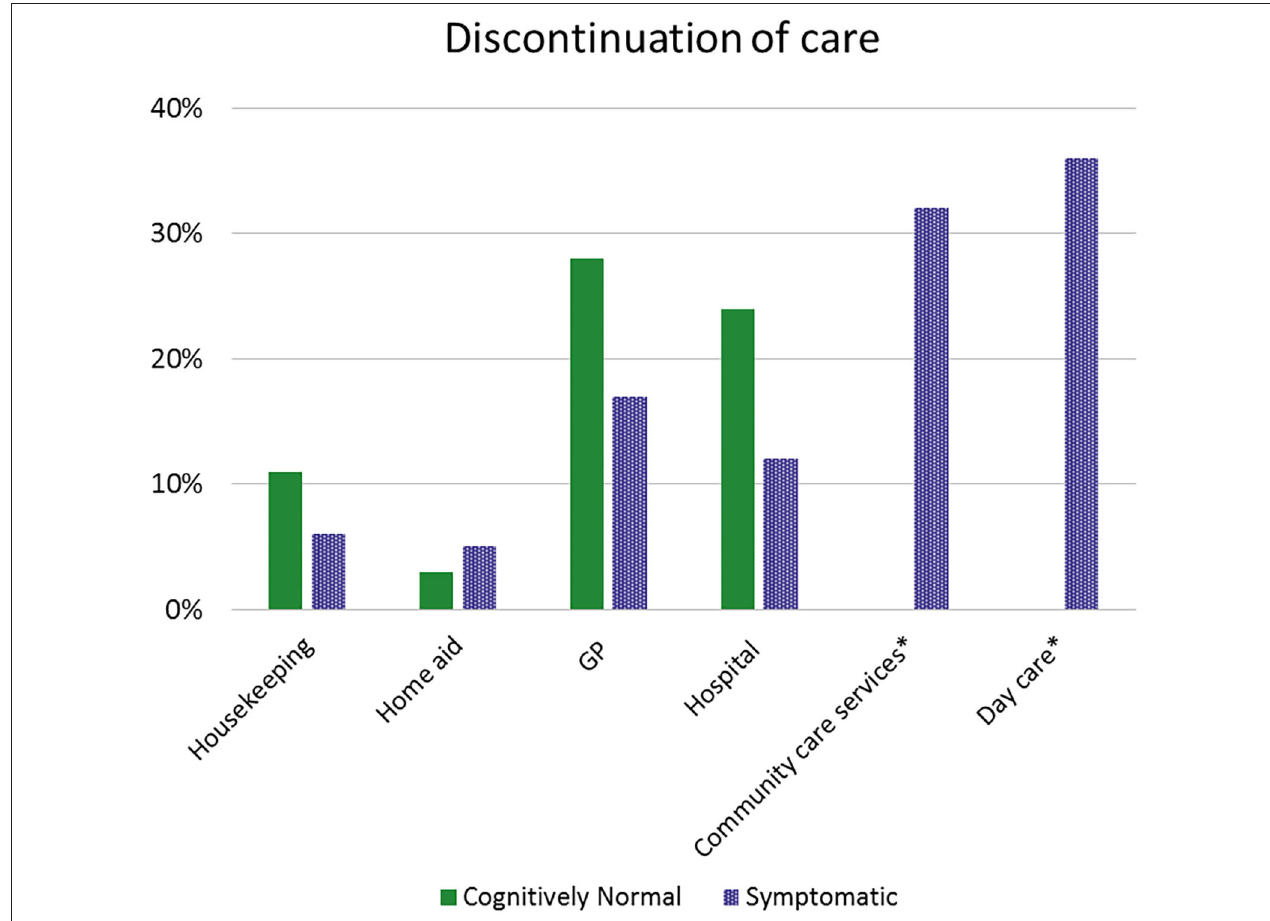
FIGURE 2 | Discontinuation of care. *Discontinuation of community care services and day care were only reported by symptomatic patients. GP, General